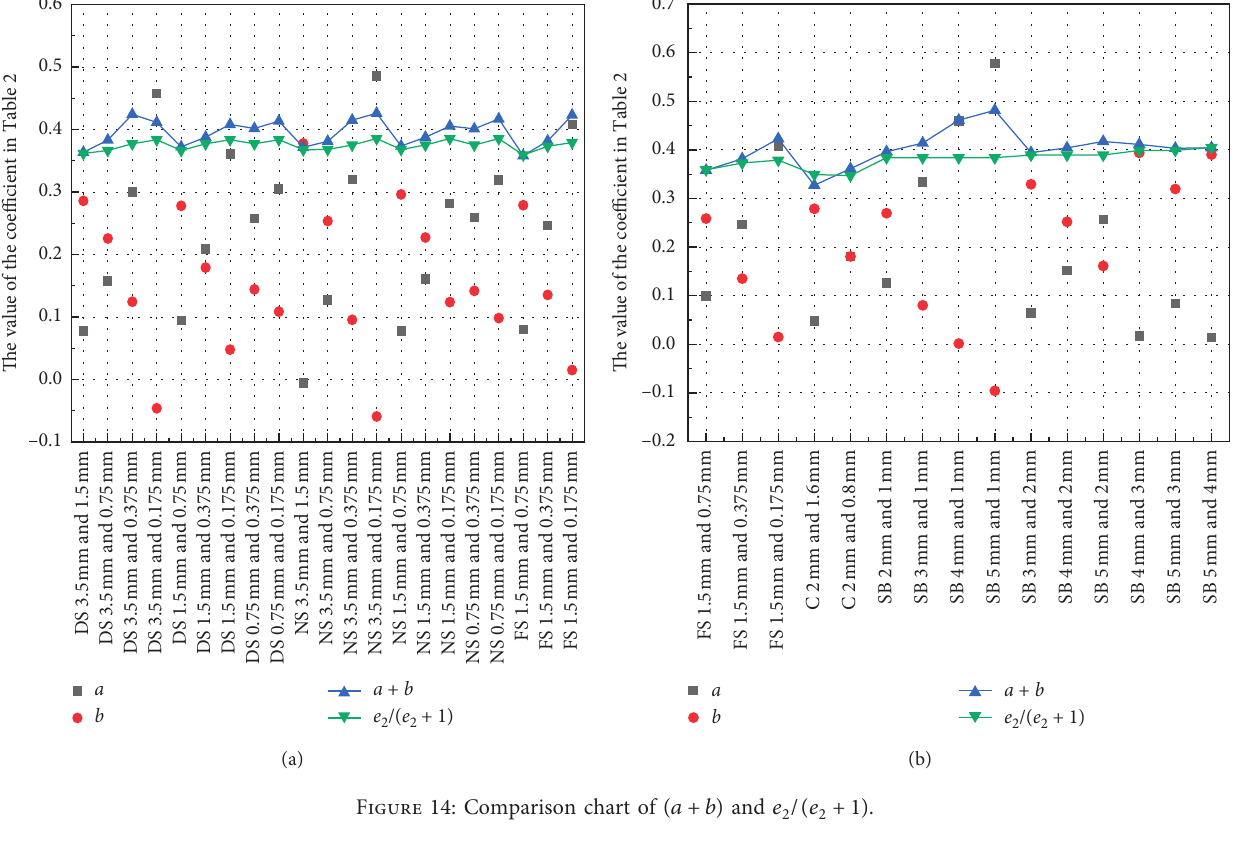
� 0, only coarse particle. (b) y 2